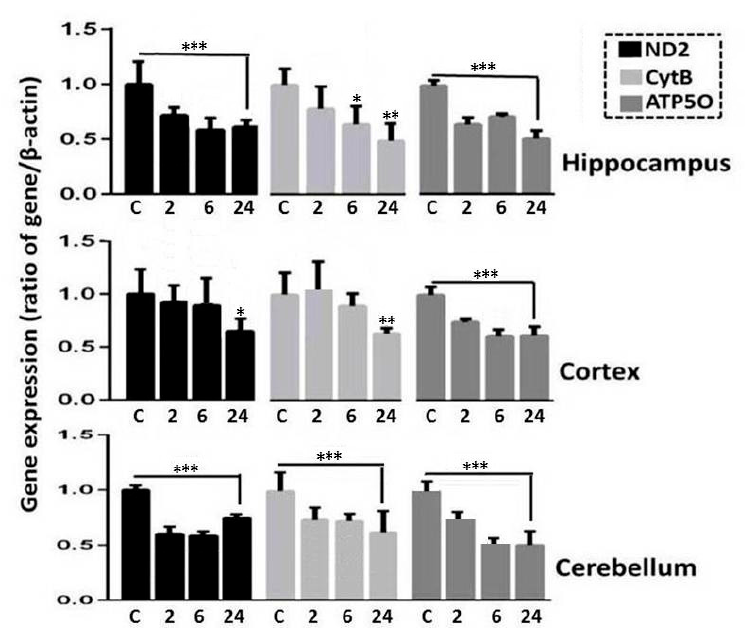
Figure 5. Change in the expression of oxidative phosphorylation genes (ND2, CytB, ATP5O) in the di ff erent rat brain regions at 2, 6, and 24 h after radiation exposure. The level of gene expression in unirradiated rats is expressed as 1. The data are presented as mean ± SD from 4–5 independent experiments. Statistical significance was set at * p < 0.05, ** p < 0.01, *** p < 0.001.